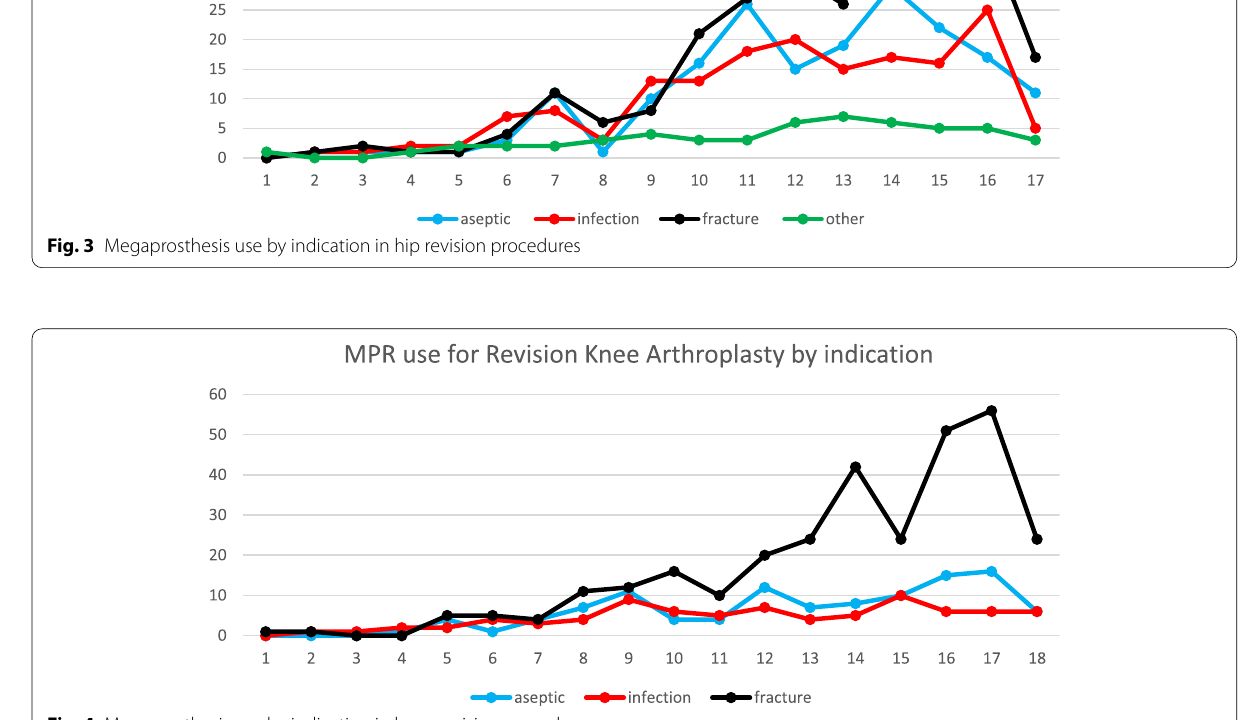
Fig. 4 Megaprosthesis use by indication in knee revision